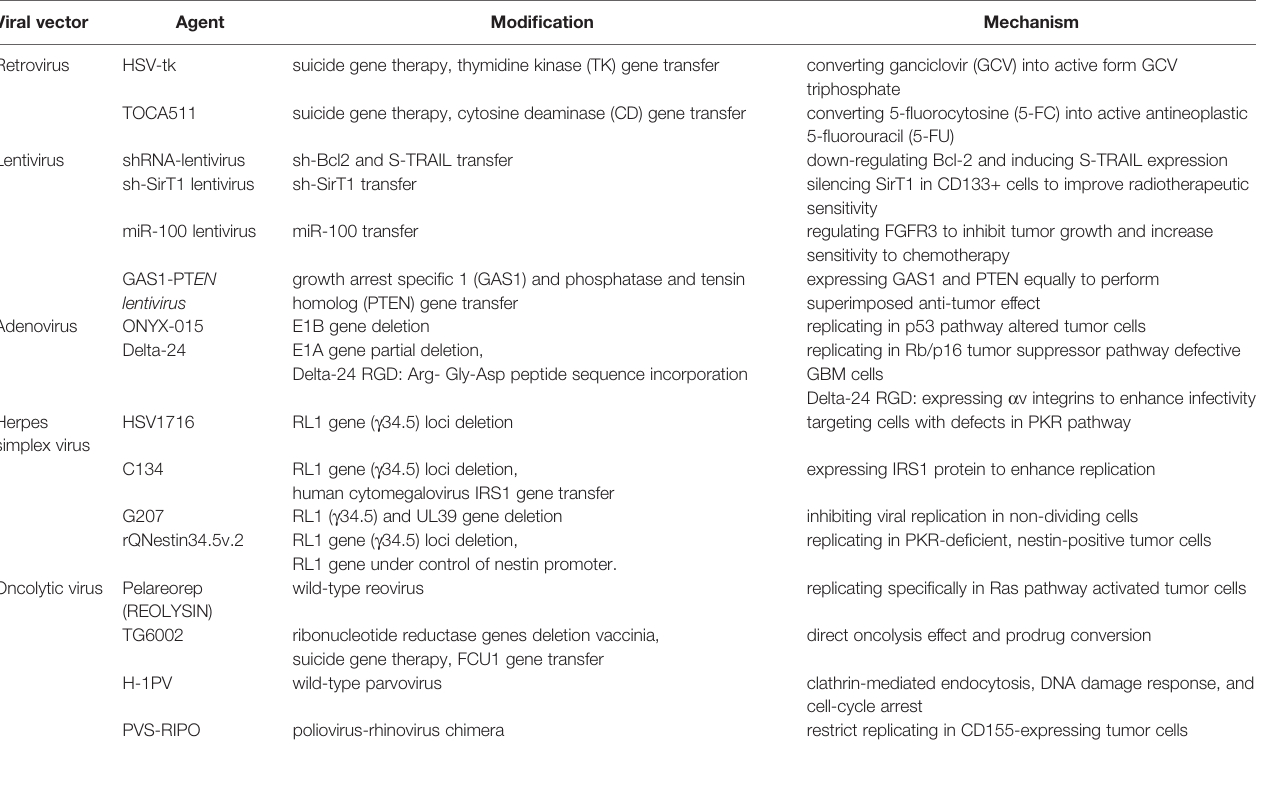
TABLE 1 | Modi fi cations and mechanisms of the viral vectors used for GBM gene therapy. Viral